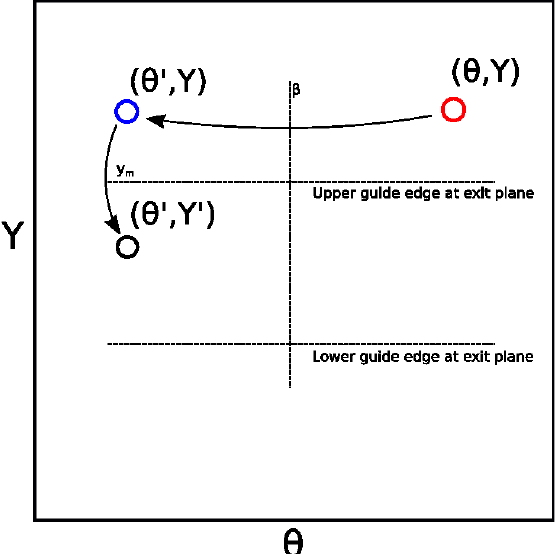
Figure 1. Illustration of the reflection of a phase space point in an inclined mirror plane, according to Equations (4) and